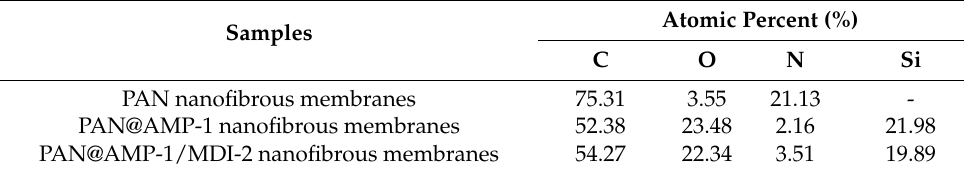
Table 1. Atomic ratios of carbon, nitrogen, oxygen and silicon on the surface of PAN, PAN@AMP-1 and PAN@AMP-1/MDI-2 nanofibrous membranes. Data are calculated from XPS. Samples